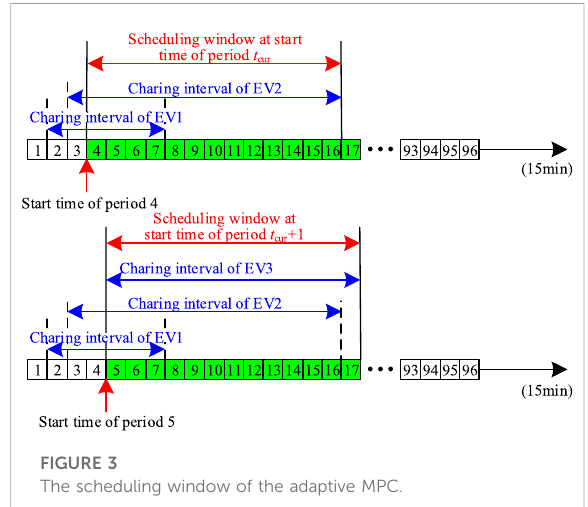
FIGURE 3 The scheduling window of the adaptive